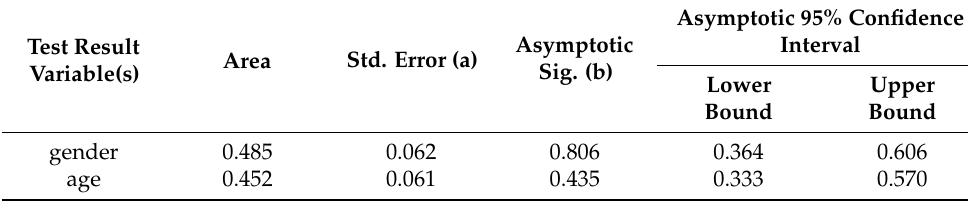
Figure 2. ROC curve that shows the predictors markers for PP type V. Table 7. Demographical data for predictor markers of PP type V